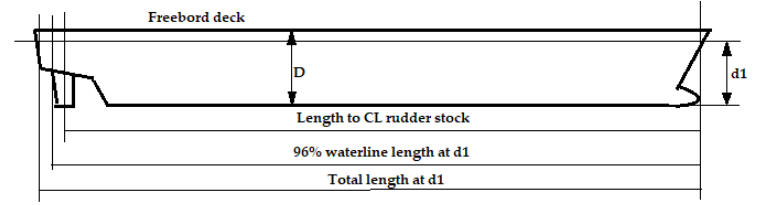
Figure 9. Load line length determination for flat keel hulls.